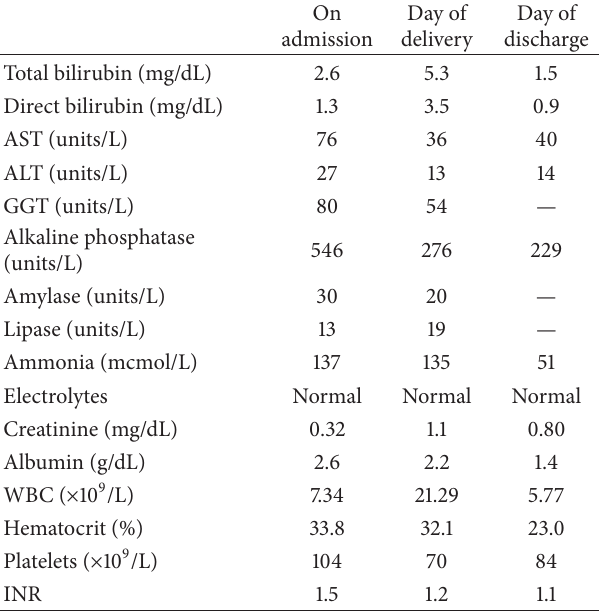
Table 1: Laboratory values during